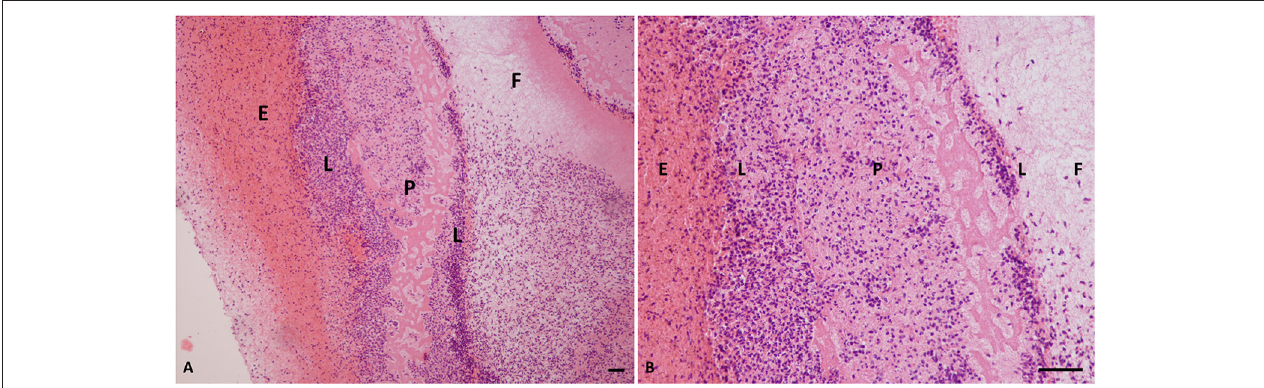
FIGURE 2 | Histology of L-PRF clot. (A) Cellular portion of a PRF clot ( × 10 magnification). (B) PRF clot ( × 40 magnification). P, platelets; E, erythrocytes; F, fibrin; L, leukocytes; PRF, platelet-rich fibrin. Scale bar = 50 micron.